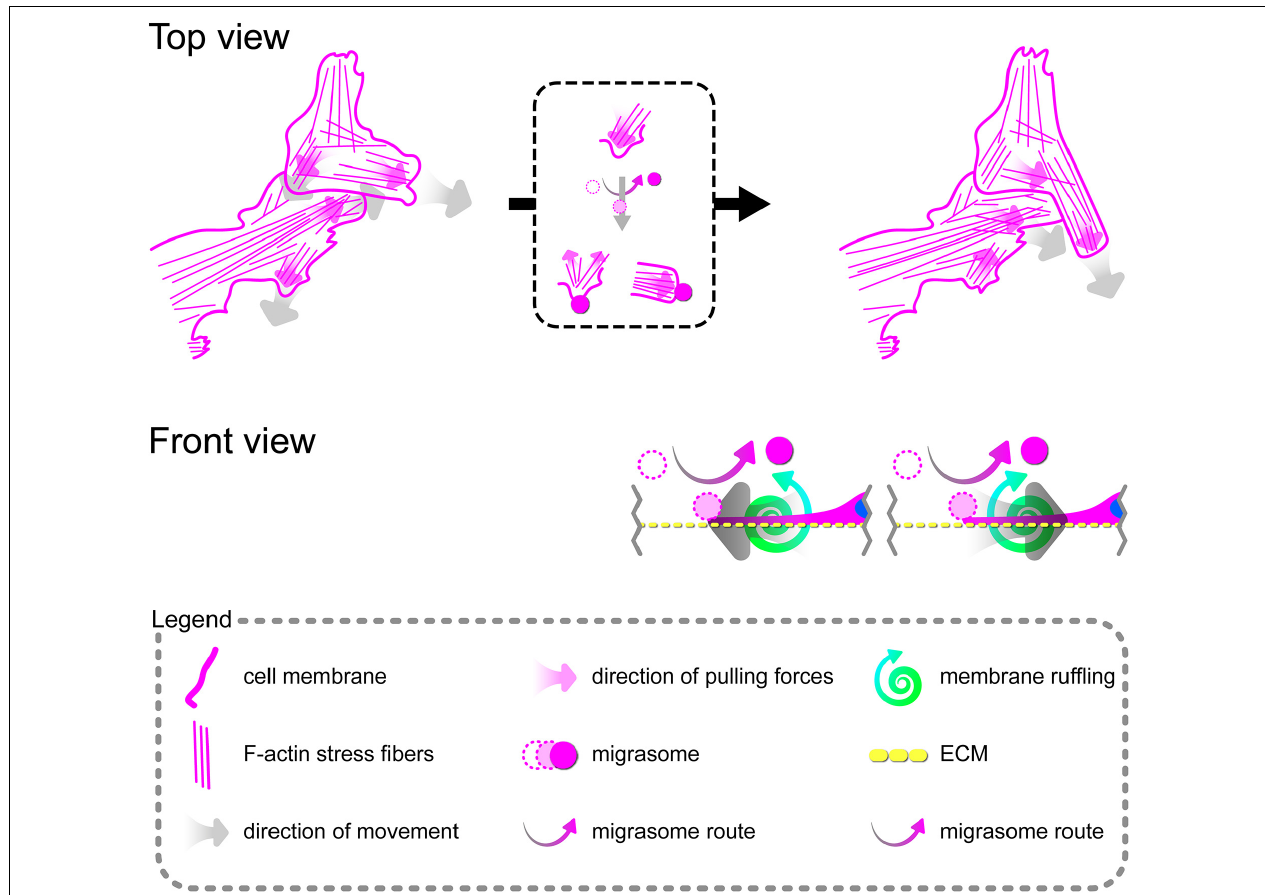
FIGURE 11 | Schematic overview of the mechanism of pHCAEC response to their interaction with